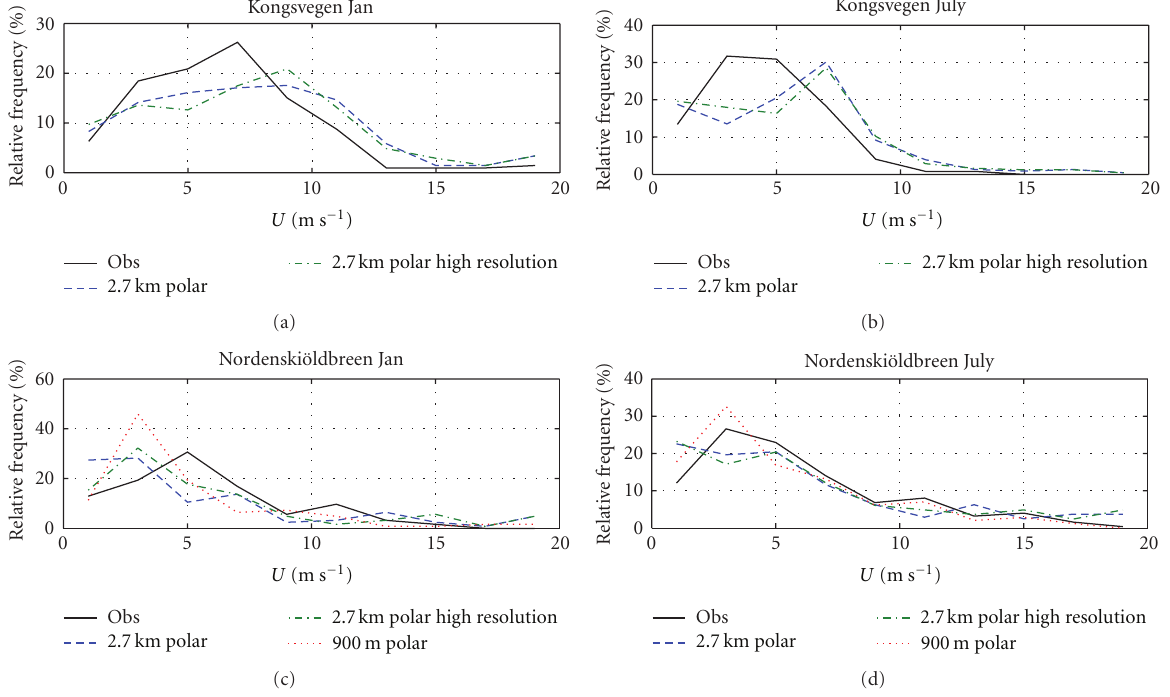
Figure 10: Frequency distribution of wind speed at Kongsvegen and Nordenski¨oldbreen.